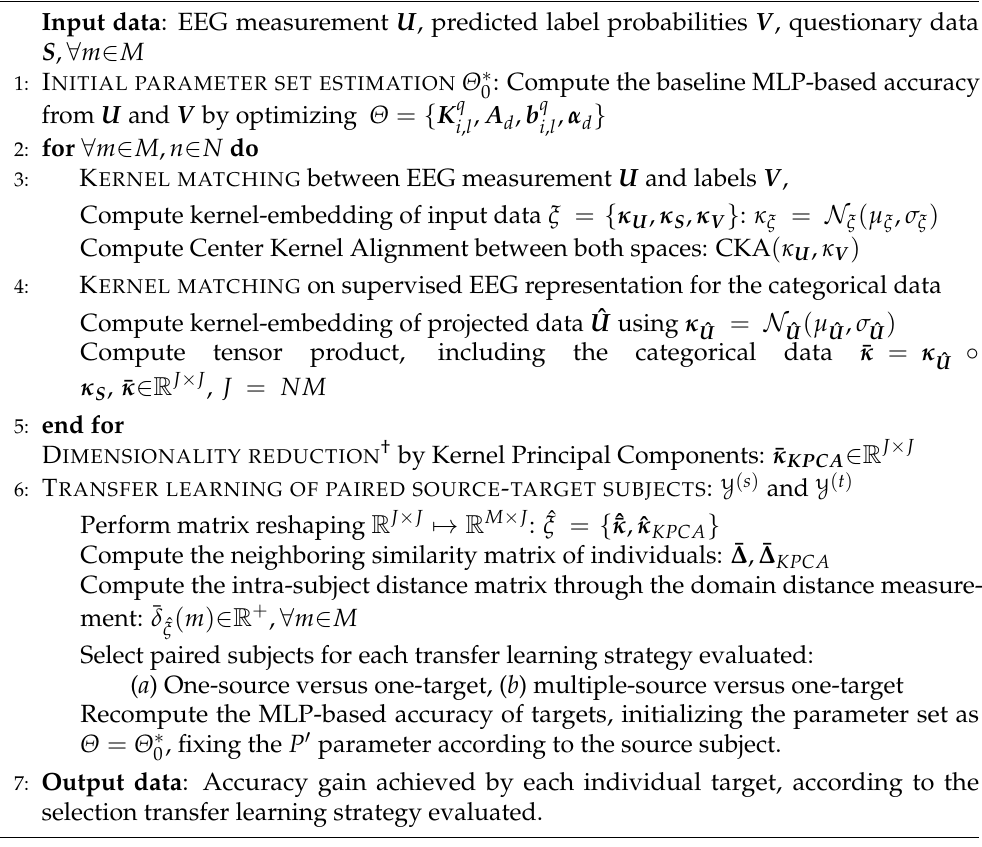
Algorithm 1 Validation procedure of the proposed approach for transfer learning with stepwise, multi-space kernel matching. † Dimensionality reduction is an optional procedure performed for comparison